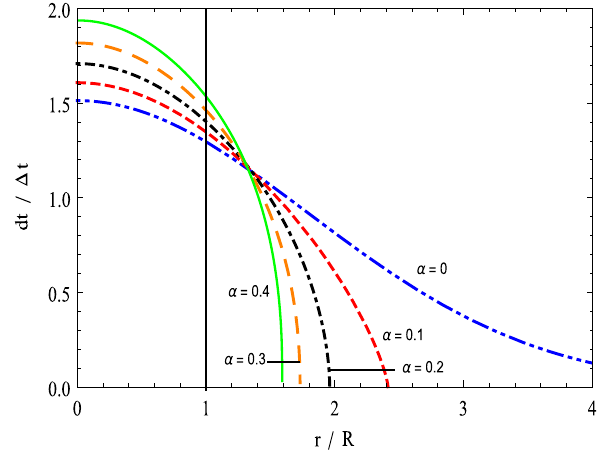
Fig. 15 The variation time dilation ( dt /(cid:2) t ) versus radial coordinate r / R for different values of α . Here r / R = 1 is the boundary of the compactobjectswhile r / R > 1describestheexteriorspace-timeregion